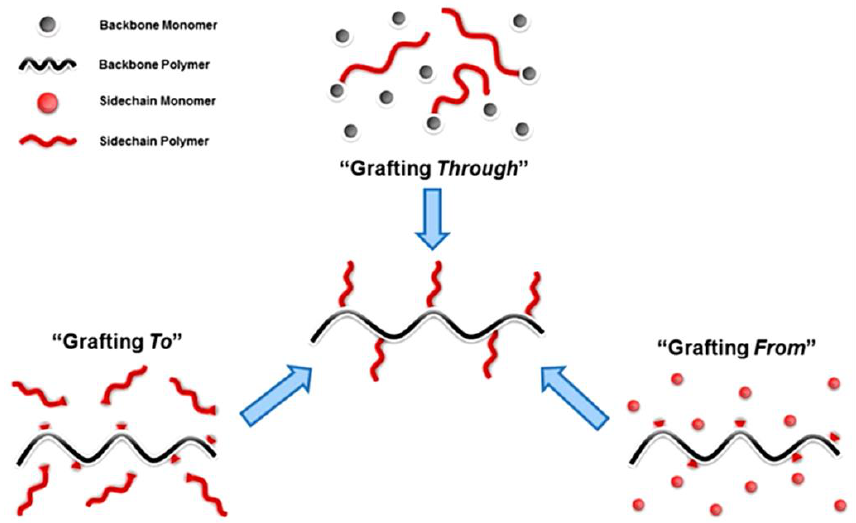
Figure 1. Generalized categories of graft copolymer synthesis: grafting through (macromonomer approach), grafting from (macroinitiator approach), and grafting to. Reproduced with permission [35].